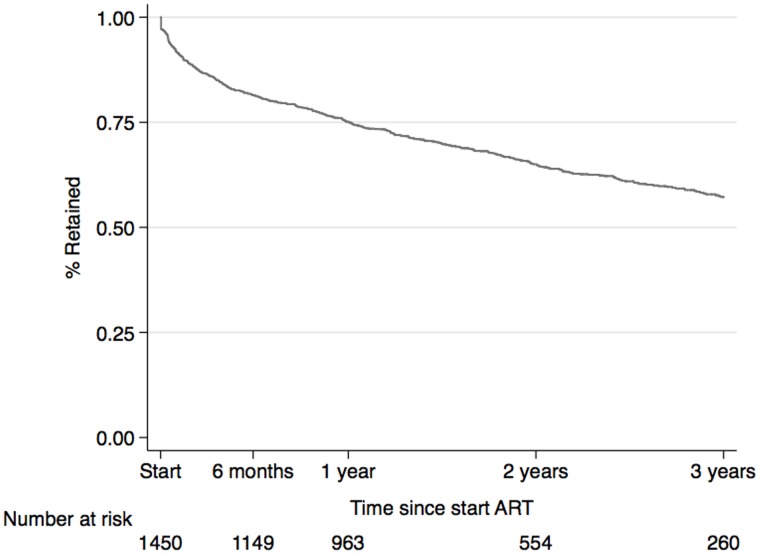
Proportion of patients discontinuing from the AmoCongo ART program over time.